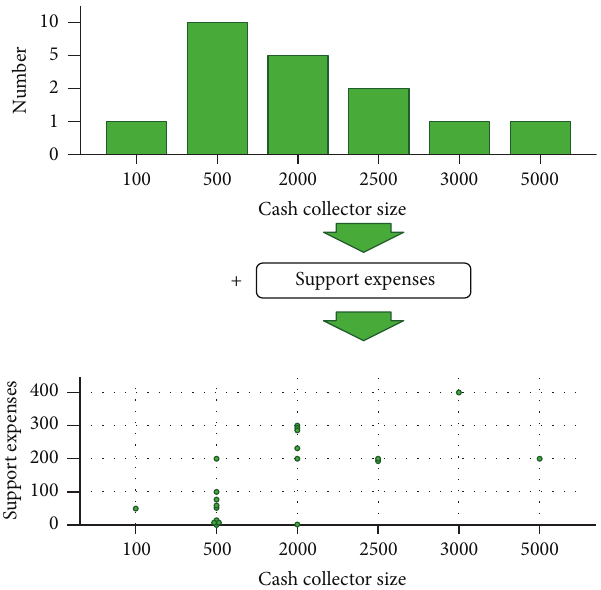
Figure 3: Dynamical changes in the number of factors.